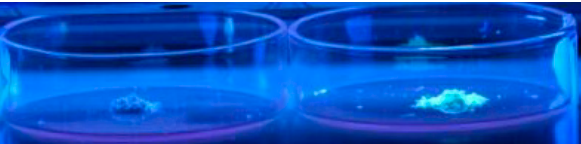
Figure 10. Solid-state photoluminescent spectra of 1 at room temperature.